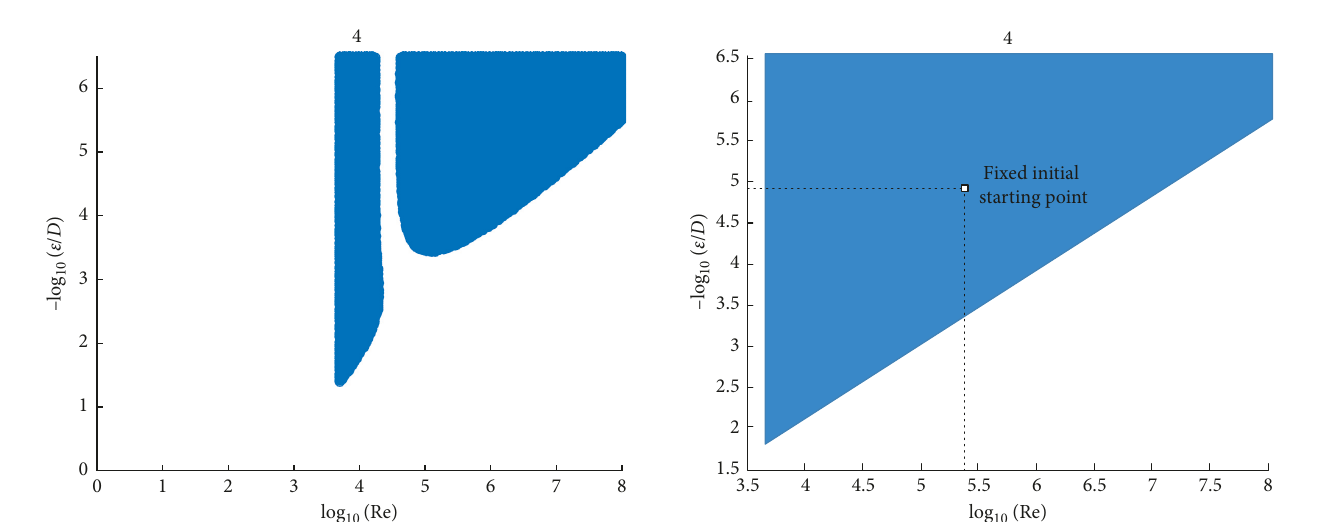
Figure 4: “Slow area” which requires 4 iterations to reach accuracy 8 regarding the “traditional” option for the starting point of 10 calculated through Equation (2), for solving Colebrook’s equation − in Halley’s and Schr¨oder’s procedure when calculation goes through the transmission factor x .